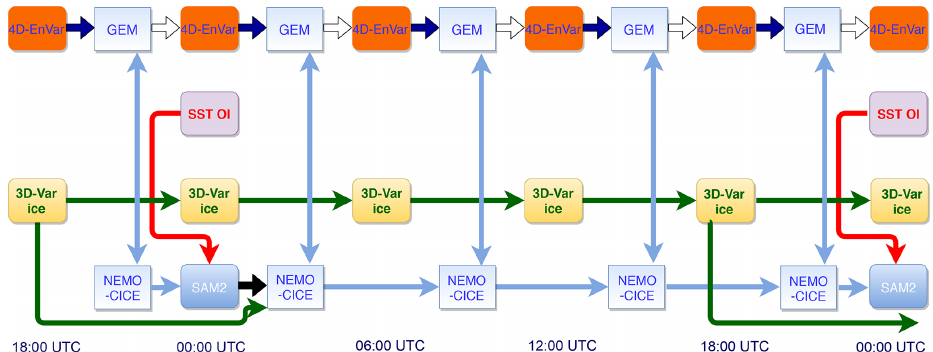
Figure 3. WCDA system (CPL) scheme. The atmospheric 4D-EnVar DA component computes analyses every 6h. The SST OI DA com- ponent computes daily analyses valid at 00:00UTC, which are assimilated using the daily SAM2 ocean DA component at 00:00UTC. The 3D-Var sea ice analyses are computed every 6h. The 3D-Var sea ice analysis computed at 18:00UTC provides the initial condition for the computation of fully coupled atmosphere–ocean background states at 00:00, 06:00, 12:00 and 18:00UTC. The separate atmospheric and ocean analyses are propagated in space and time using the fully coupled GEM–NEMO–CICE